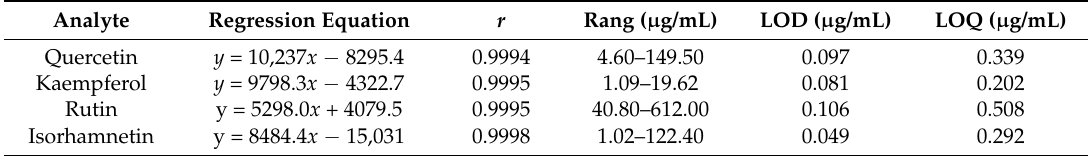
Table 3. Linear regression data, LOD, and LOQ of four flavonoids in Flos sophorae.